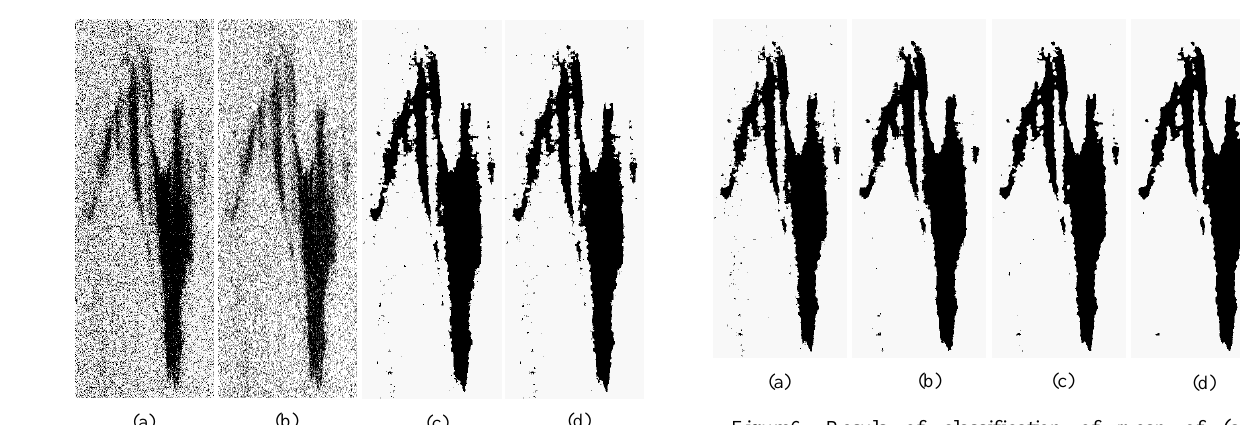
Figure6: Resuls of classification of mean of (a) Magnitude and power measurements of HH and VV polarizations and (b) Pauli decomposition. (c) Krogager decomposition. (d) Freeman decomposition in window sizes of 5×5, 7×7, 3×3 and 5×5 respectively .